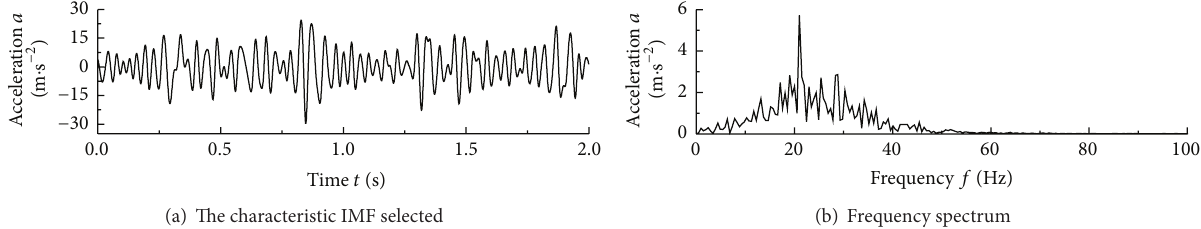
Figure 17: Analysis results of the signal presented in Figure 16 by improved EMD: (a) the characteristic IMF and (b) FFT spectrum.